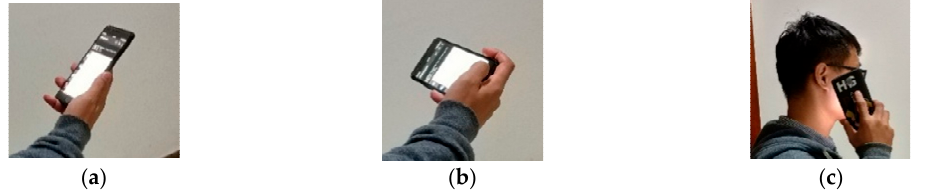
Figure 4. Three Using-modes of Smartphone. ( a ) Normal mode as Mode 1; ( b ) Landscape mode as Mode 2; ( c ) Call mode as Mode 3.